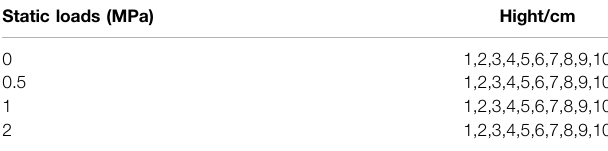
TABLE 1 | Experimental program. Static loads (MPa)